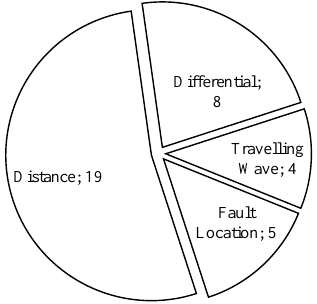
Figure 12. Patents from Figure 11, by